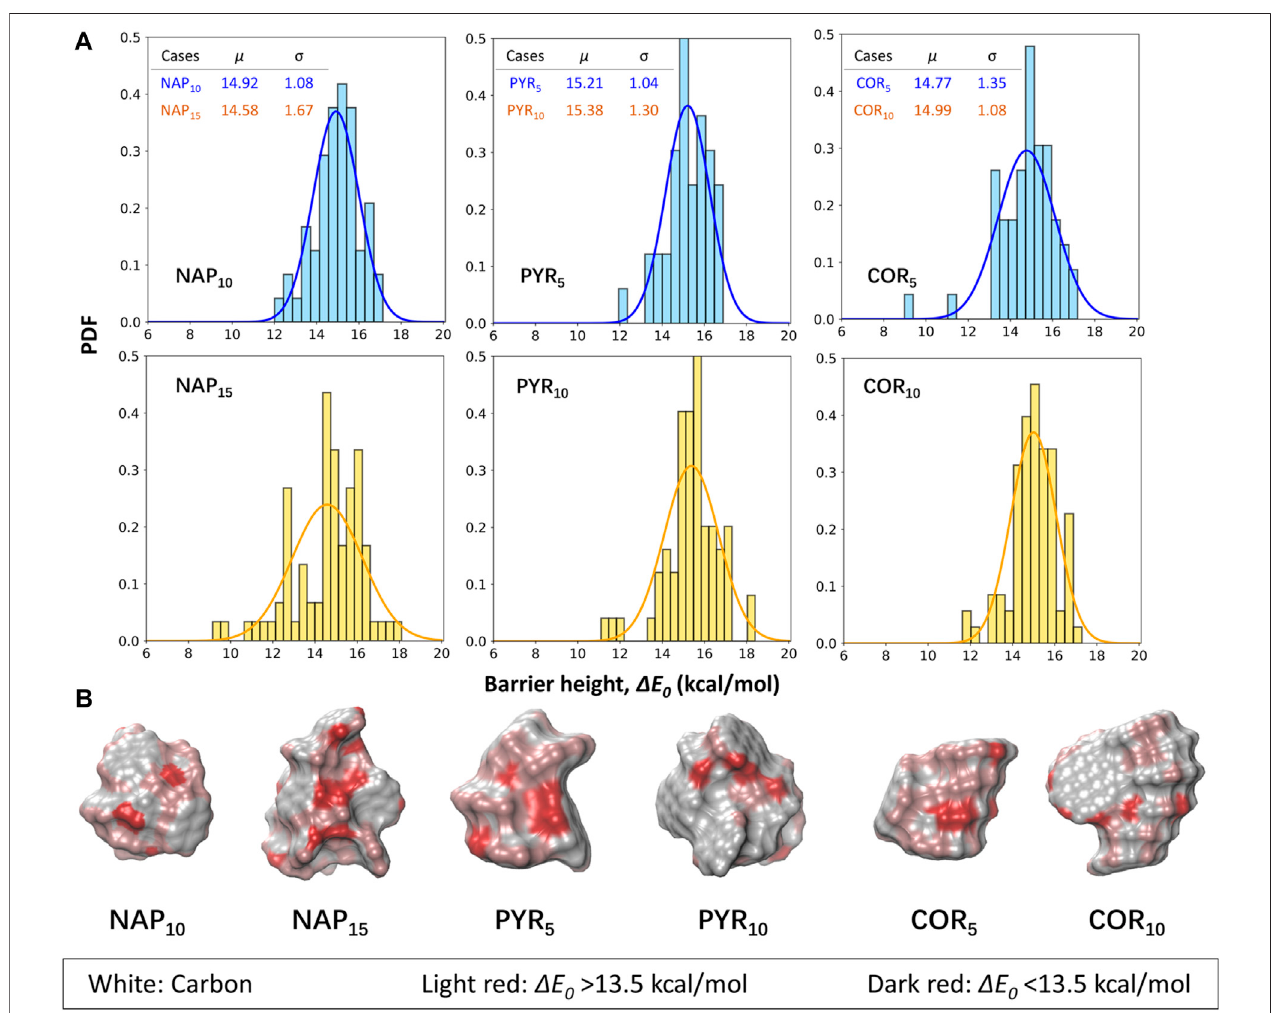
FIGURE4|(A) Thebarrier heights forhydrogen abstractions fromselectednaphthalene (NAP), pyrene (PYR)and coronene(COR) clusters byHradicals. Theblue barsrepresenttheresultsofthesmallerclusters,whilethelargeronesareillustratedbyyellowbars.Acorrectionof2.5 kcal/molisincludedtoaccountfortheerrorsinthe frozen algorithm. μ and σ represent the mean and standard deviation of the fi tted gaussian distributions. (B) The spatial distributions of barrier heights on each surface hydrogen atoms. The white, light red and dark red refer to surface carbons, surface hydrogens with Δ E 0 > 13.5 kcal/mol, and surface hydrogens with Δ E < 13.5 kcal/mol, 0